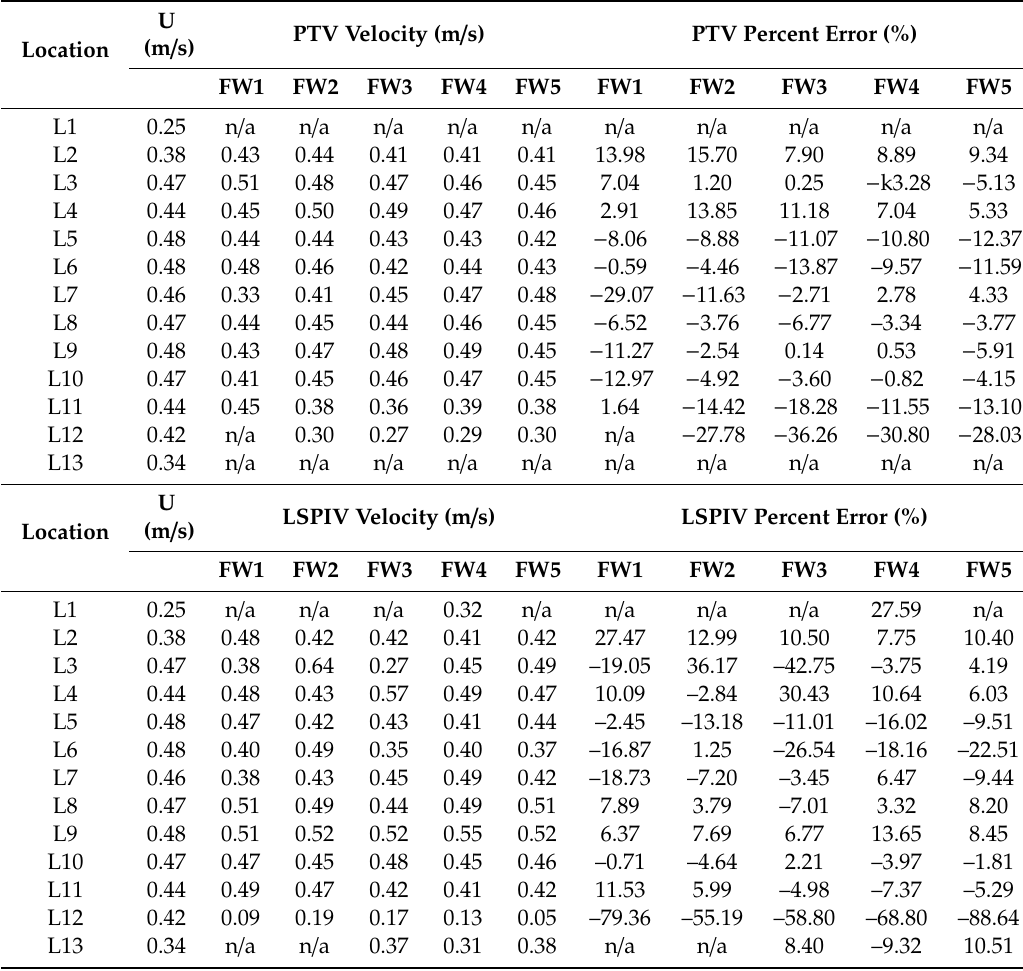
Table A1. PTV and LSPIV results for each location compared to reference measurements on the Noce